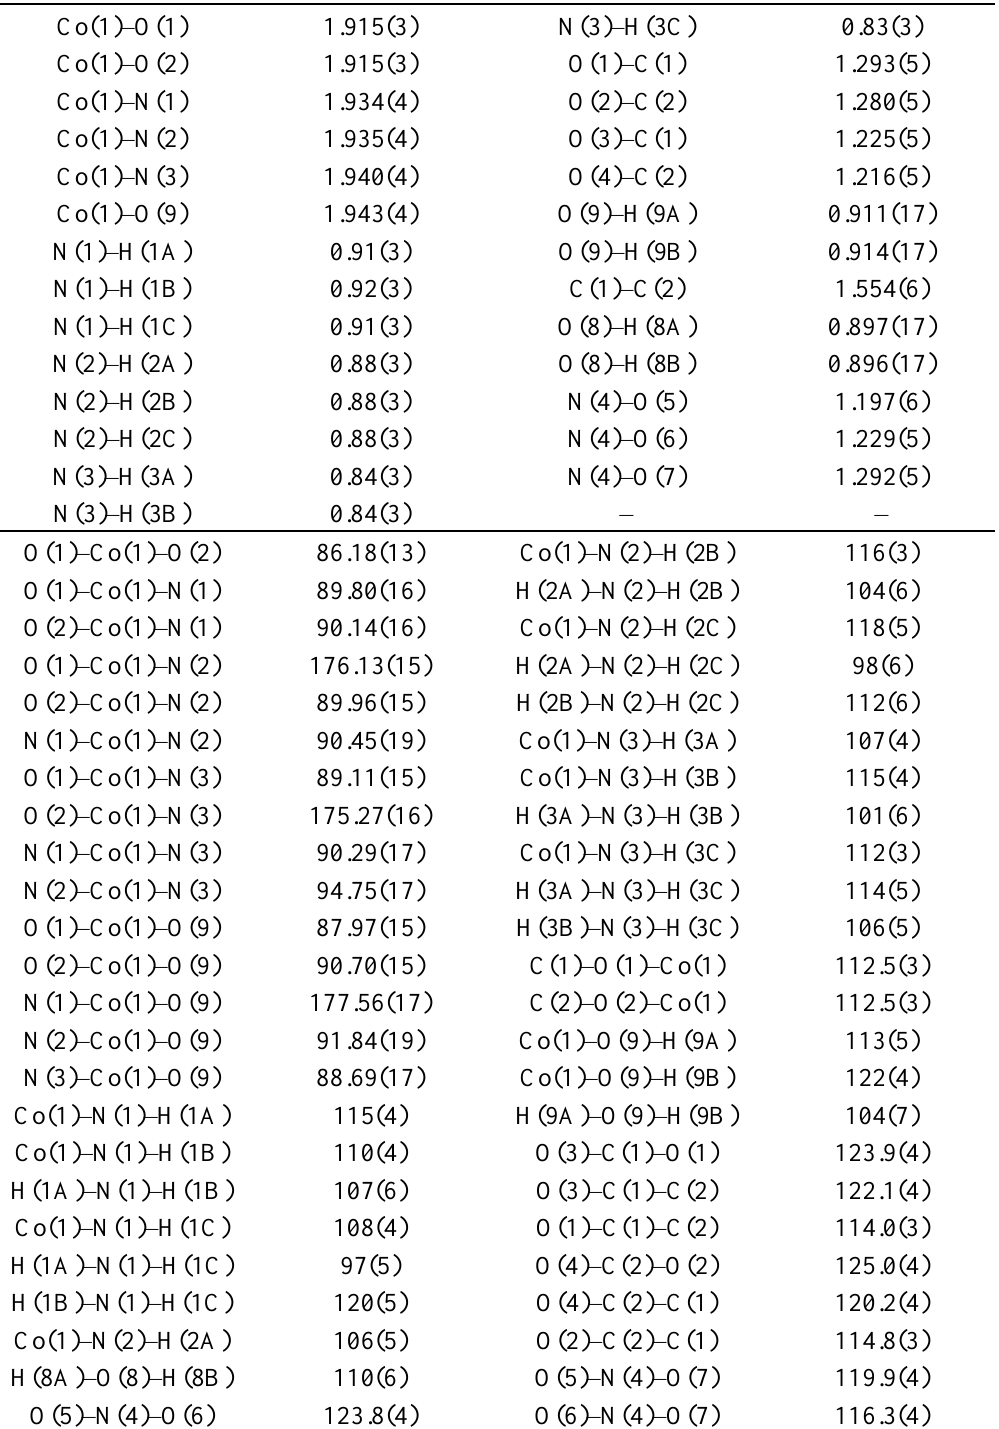
Table 2. Selected bond lengths (Å) and angles (°) for fac -[Co(NH 3 ) 3 (C 2 O 4 )(H 2 O)]NO 3 ·H 2 O ( 2